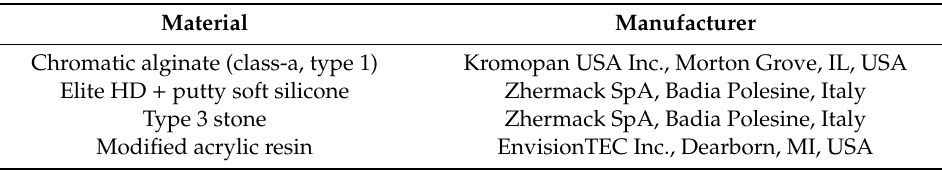
Table 1. Materials used in the present